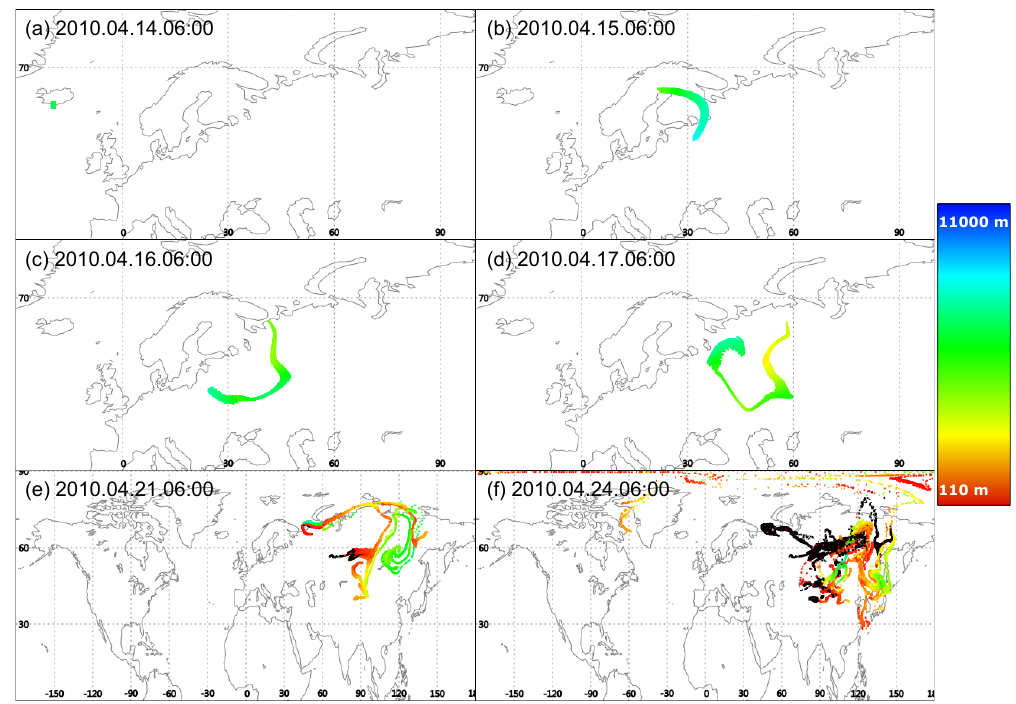
Figure 1. Simulation of the spreading of volcanic ash particles from the Eyjafjallajökull volcano’s eruption at different time instants in the form of “year.month.day.hour:minute” indicated in the panels’ label ( a – f ). 30 × 30 × 30 particles of r = 5 µ m and (cid:36) p = 2000 kgm − 3 are initiated in a rectangular cuboid of size of 100 km × 100 km × 4 km at 63.63 ◦ N, 19.6 ◦ W, at the altitude of 7 km on 14 April 2010 at 06 UTC. Simulation is initialized with the parameters on the left of Figure A1. Colorbar indicates the altitude of the particles, black color marks deposited